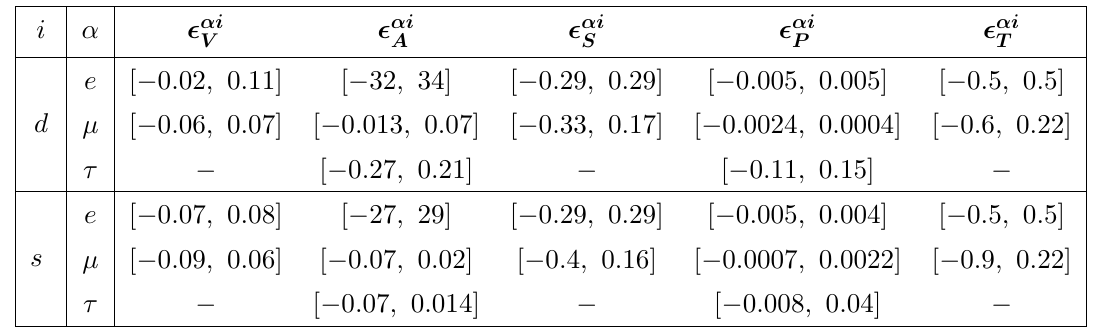
− -meson decays, assuming them ( s )